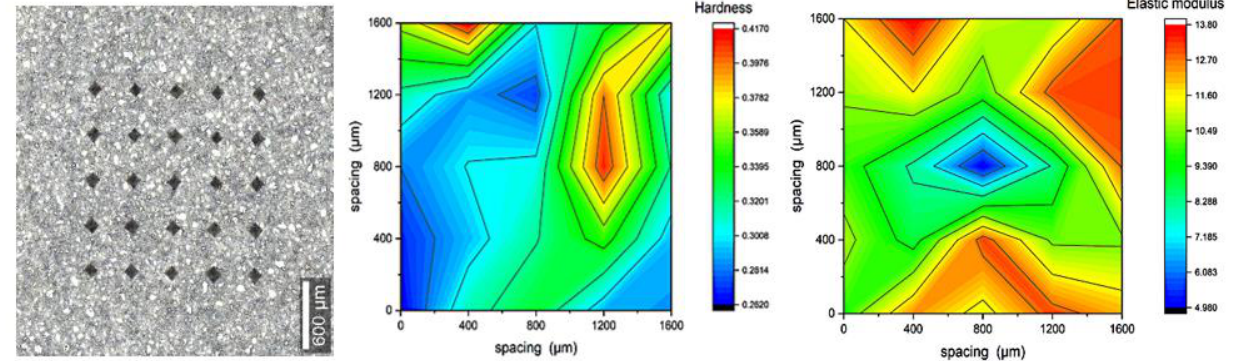
Figure 12. Indentation results for polished cores of 30% FER-added Class-H cement with 25 indents, represented as maps of hardness (avg. of 0.256 GPa) and elastic modulus (avg. of 7.88 GPa).